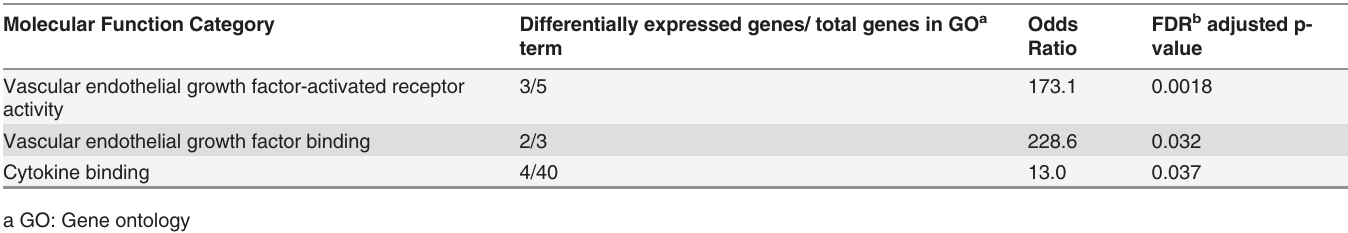
Table 6. Molecular functions enriched for genes differentially expressed between the neurocognitive impairment and no impairment groups. Molecular Function